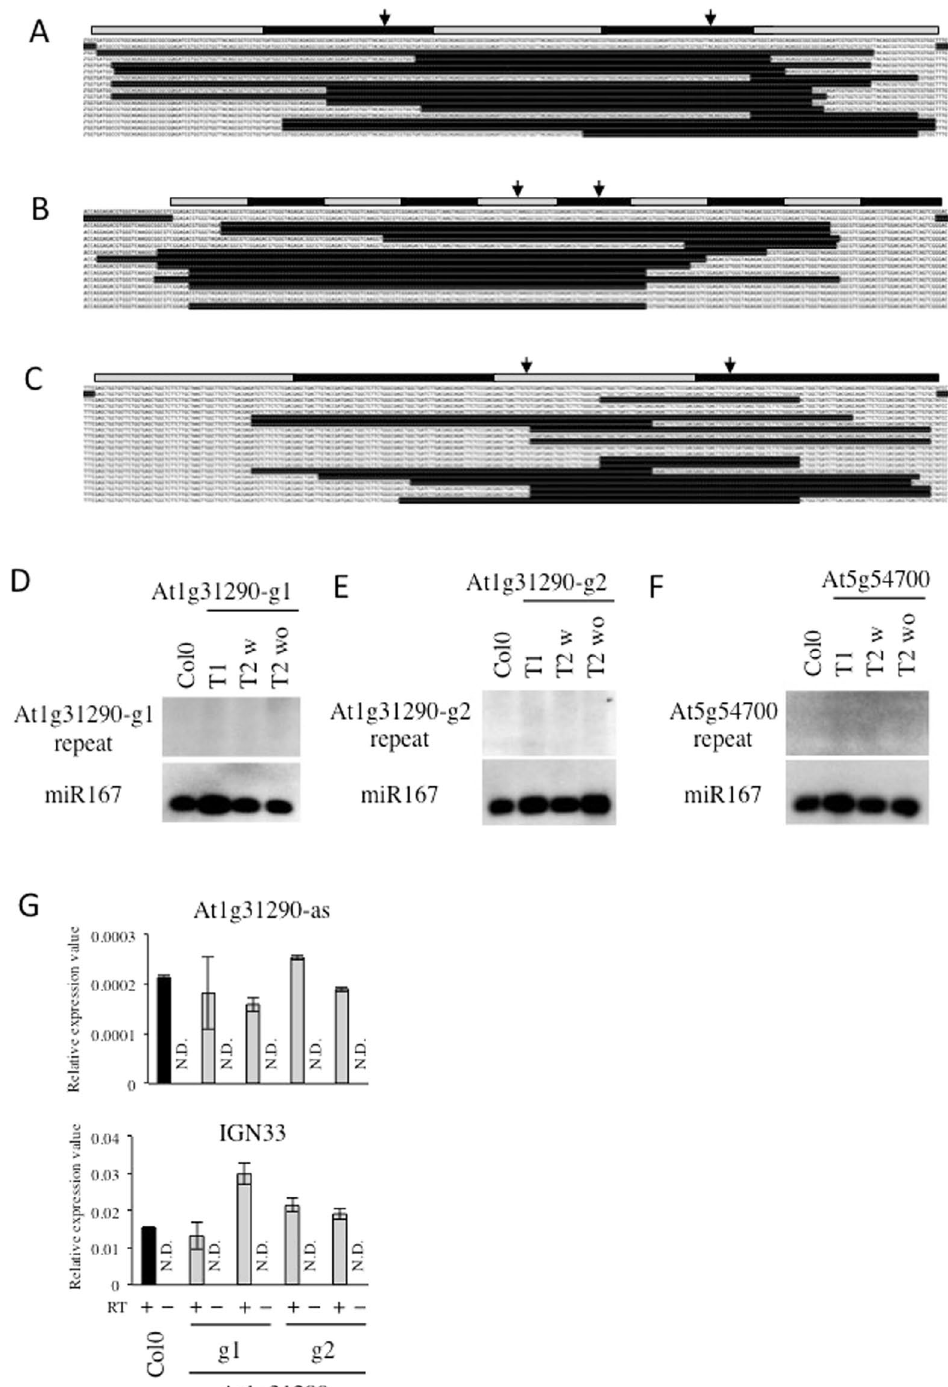
Figure 3. diRNAs are not detected at endogenous repeat regions. ( A – C ) The repeat regions and the targeted T1 sequences are shown for the ( A ) At1g31290 repeat1, ( B ) At1g31290 repeat2, and ( C ) At5g54700, respectively. The top gray and black horizontal bars represent the repeats, and the CRISPR/Cas9 target sites are indicated by arrows. The sequence of the repeats is below the gray/black schematic. Below the reference repeat sequence are the sequencing results from independent T1 plants. See also Supplemental Figs 4 and 5. ( D – F ) Northern blot analysis for small RNAs in the indicated Col0 control, T1, T2 with CRISPR/Cas9 transgene (T2 w) or without CRISPR/Cas9 transgene (T2 wo). ( D ) At1g31290 repeat1, ( E ) At1g31290 repeat2, and ( F ) At5g54700, respectively. miR167 was probed as control. Northern blotting image was cropped nearby signals. ( G ) qRT- PCR detection of antisense transcripts in At1g31290 repeats targeted by CRISPR/Cas9. At1g31290-as indicates At1g31290 antisense transcript. IGN33 was analyzed as control. Black bar; Col0 with RT, gray bar; At1g31290 targeting CRIPR/Cas9 with RT, white bar; without RT control. N = 3. N.D.; not